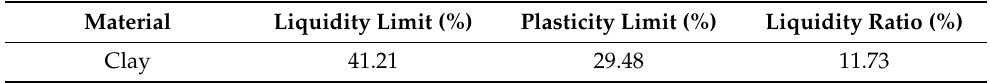
Table 3. Physical parameters of clay.